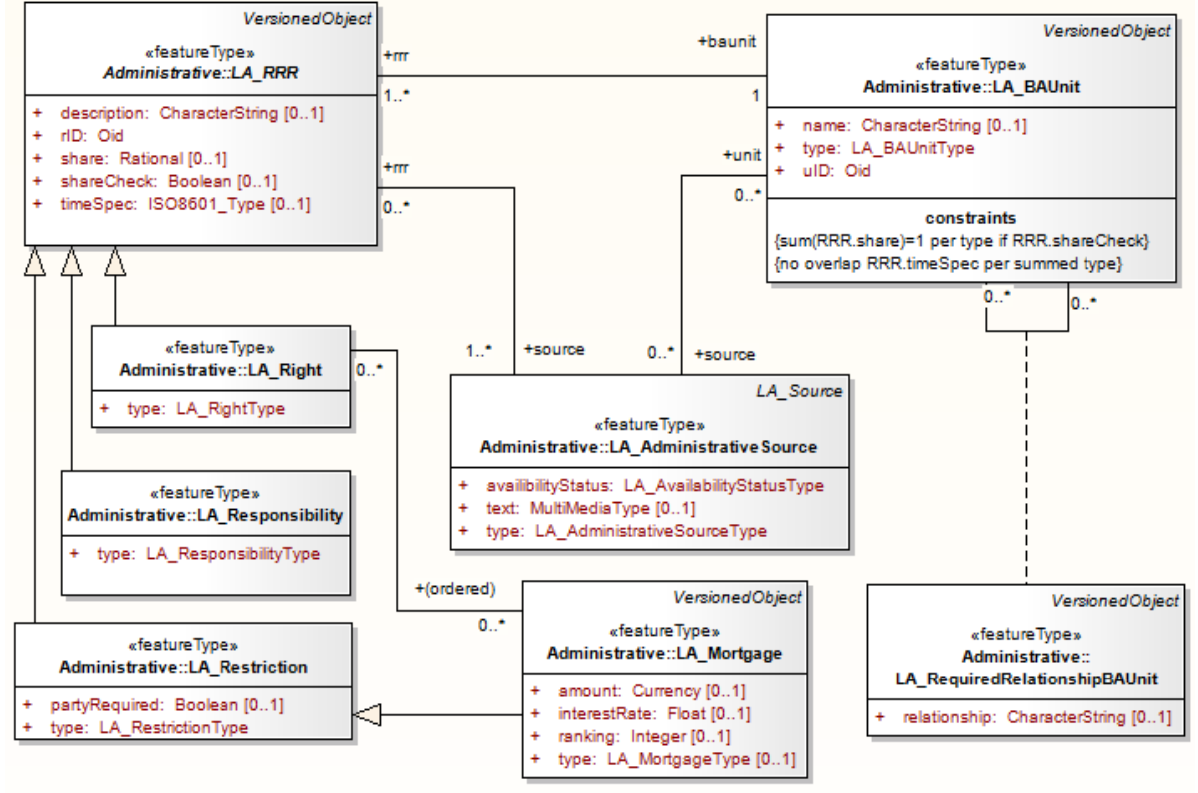
Figure 4. Administrative package classes (ISO,